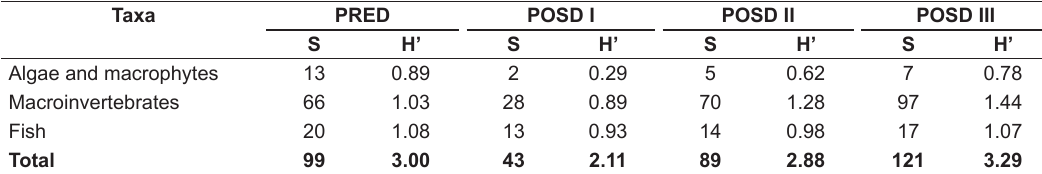
Table 4. Richness (S) and Shannon-Wiener diversity index (H’) values for aquatic biota in the sampled periods (pre- disturbance - PRED; post-disturbance I - POSD I; post-disturbance II - POSD II; and post-disturbance III -